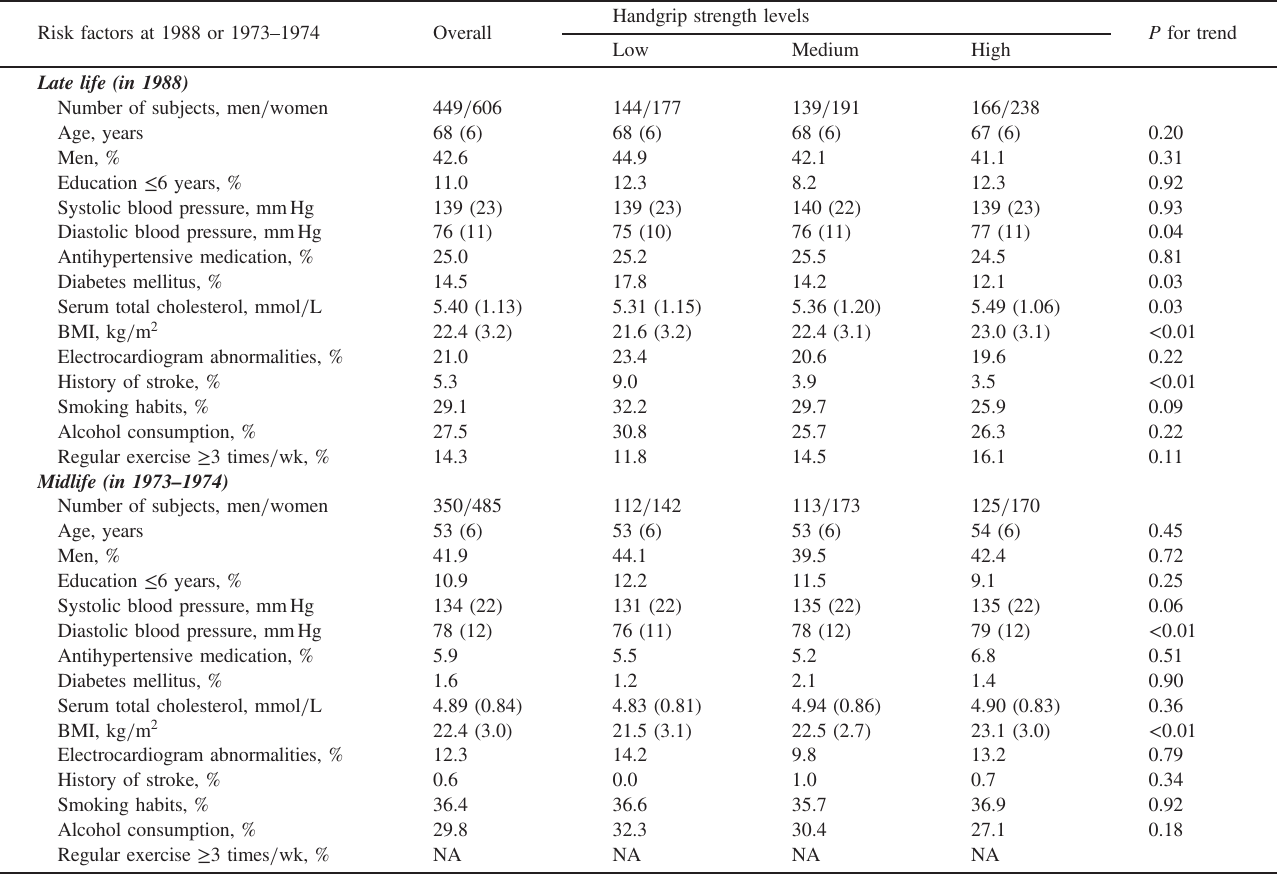
Regular exercise ≥ 3 times = wk, % NA NA NA NA BMI, body mass index; NA, not available. Values are represented as the mean (standard deviation, or